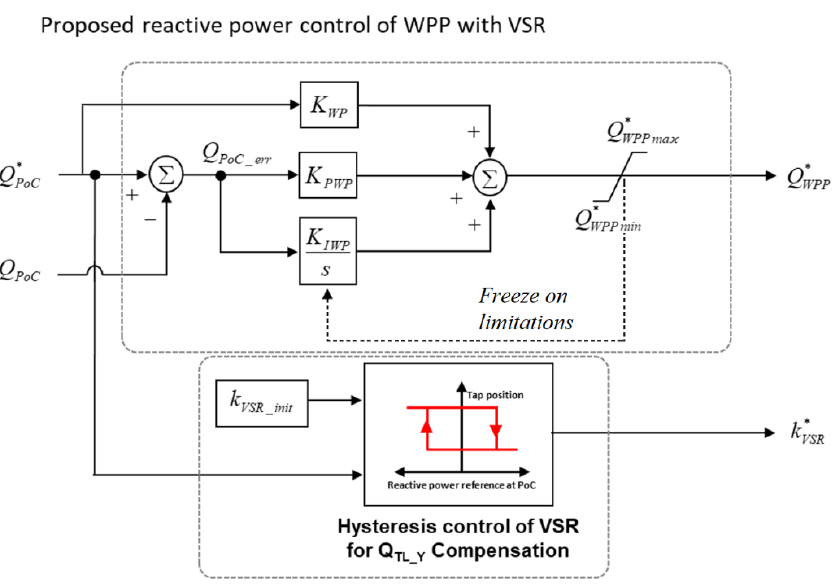
Figure 8. Block diagram of proposed reactive power control of a WPP with a VSR.